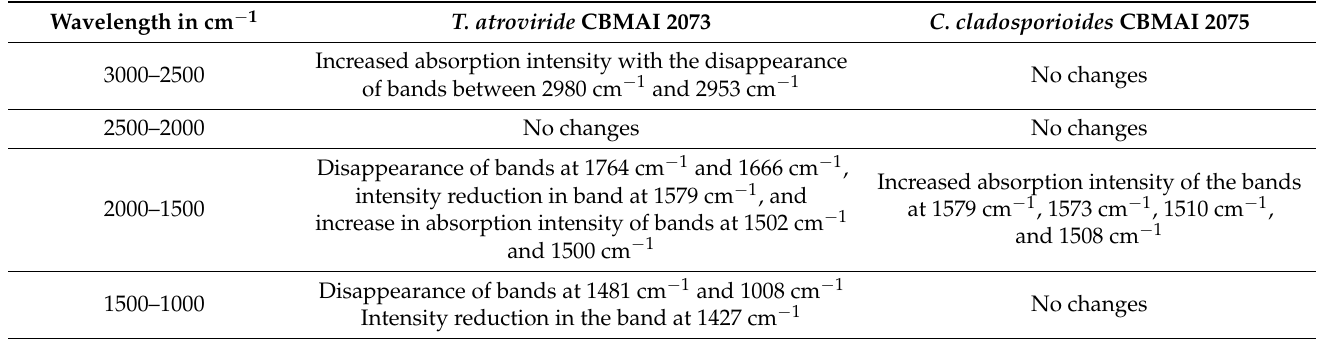
Figure 8. FTIR spectra of PET1 and PET2 polymers after 40 days in contact with T. atroviride CBMAI 2073 and C. cladosporioides CBMAI 2075. Note. Culture media PDB, t = 28 ◦ C, shaking at 150 rpm. The FTIR analysis was performed in duplicate treatments, indicated as A and B in the figure. Table 7. Chemical modifications to PET2 after fermentation with T. atroviride and C. cladosporioides using FTIR